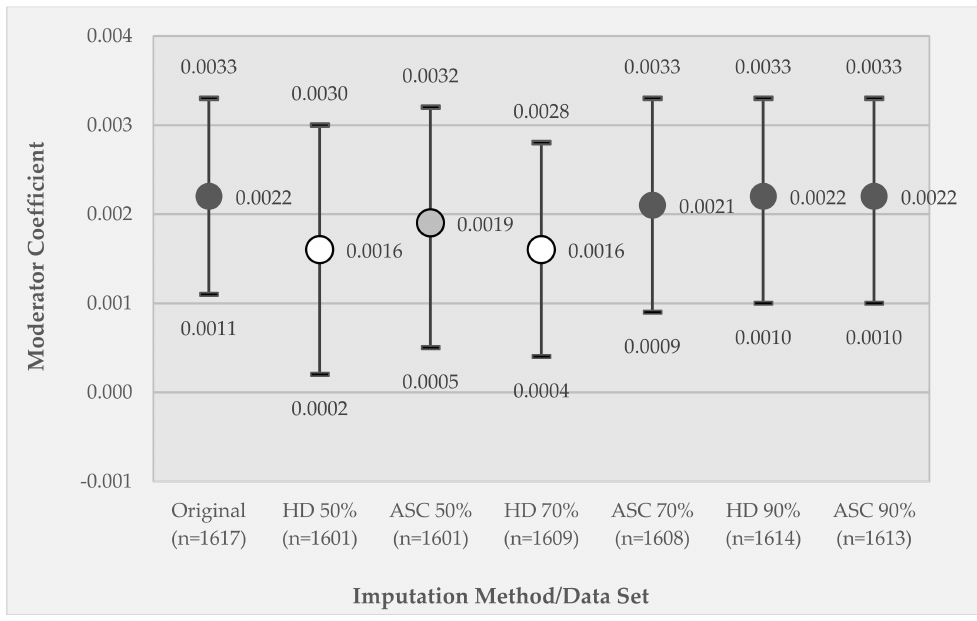
Figure 6. Results for the imputed data for Model 2, GEE coefficients of the effect of the moderator variable (relative disadvantage X substance use) on momentary stress. Coefficients are reported for the original data set (100% retained) and for each combination of imputation technique (hot deck (HD) or activity space centroid (ASC)) applied to different percentage retained data sets (50% retained (50% imputed), 70% retained (30% imputed), and 90% retained (10% imputed)). Circle markers represent coefficient values; whiskers represent 95% confidence intervals. Marker fill indicates coefficient significance, where dark gray is p < 0.005, light gray is p < 0.01, and white is p <